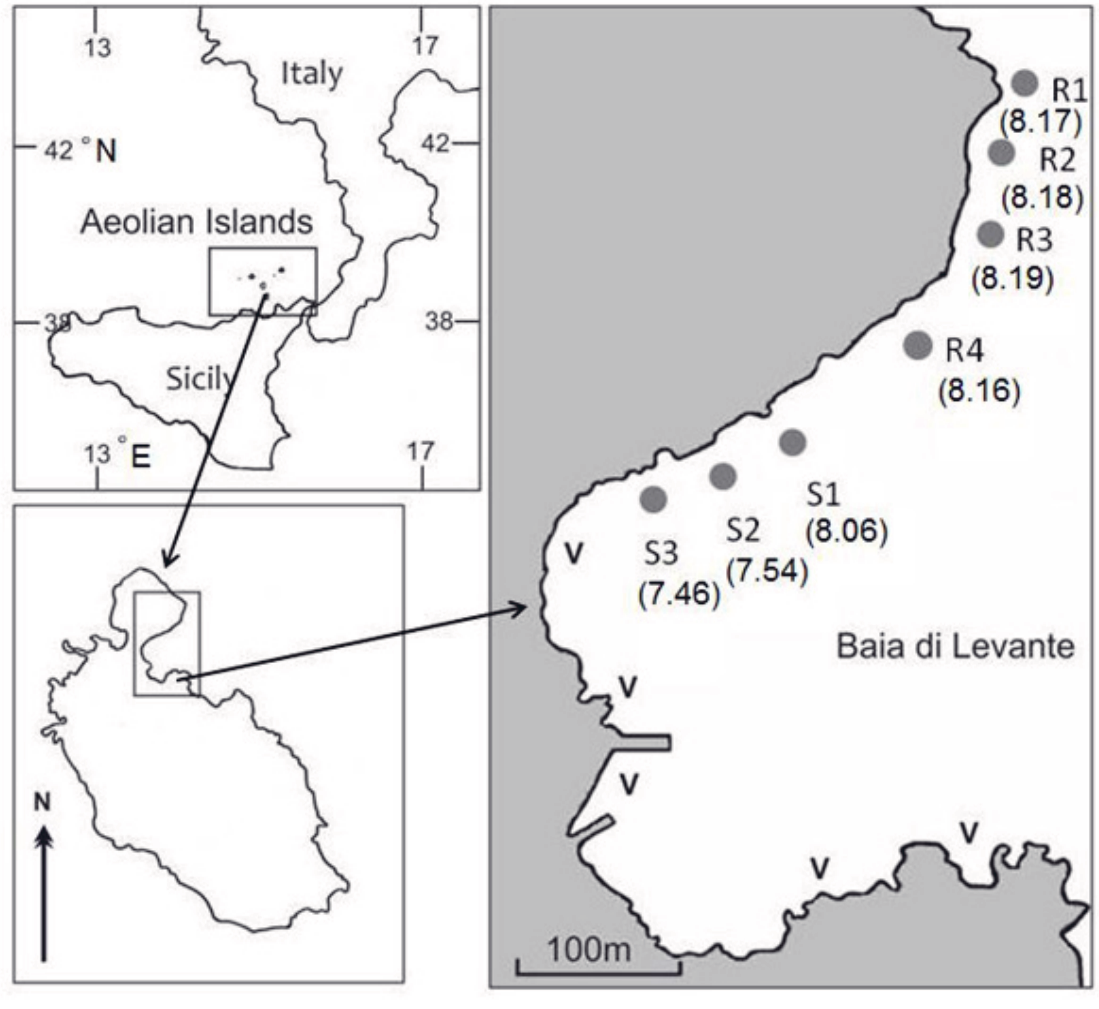
Figure 1. Location of Baia di Levante (Vulcano Island, NE Sicily), showing sampling stations S1–S3 and R1–R4, V = CO 2 seeps. Data in brackets show mean pH of each station ( n =